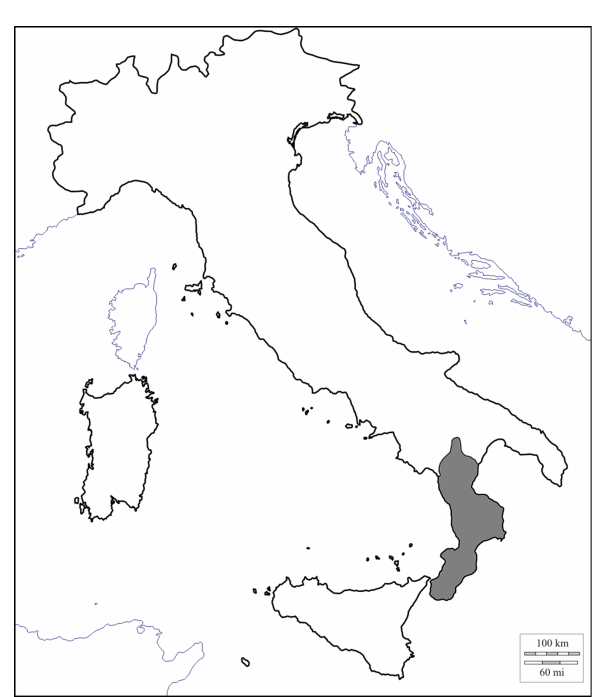
Figure 3. Distribution map of Microtus brachycercus (redrawn from Bezerra et al. 2016).